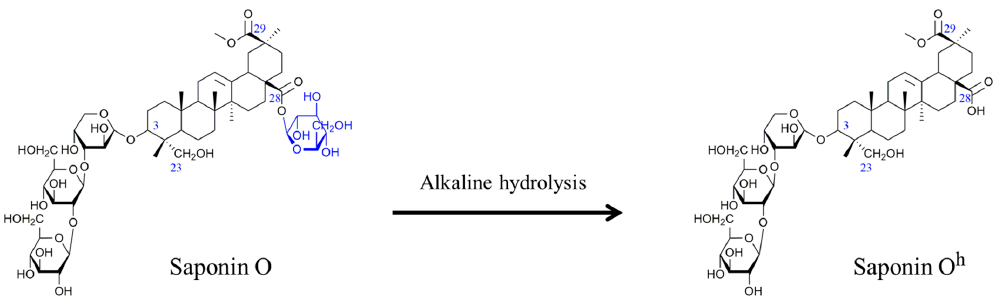
Figure 1. Alkaline hydrolysis of Saponin O to Saponin O h .